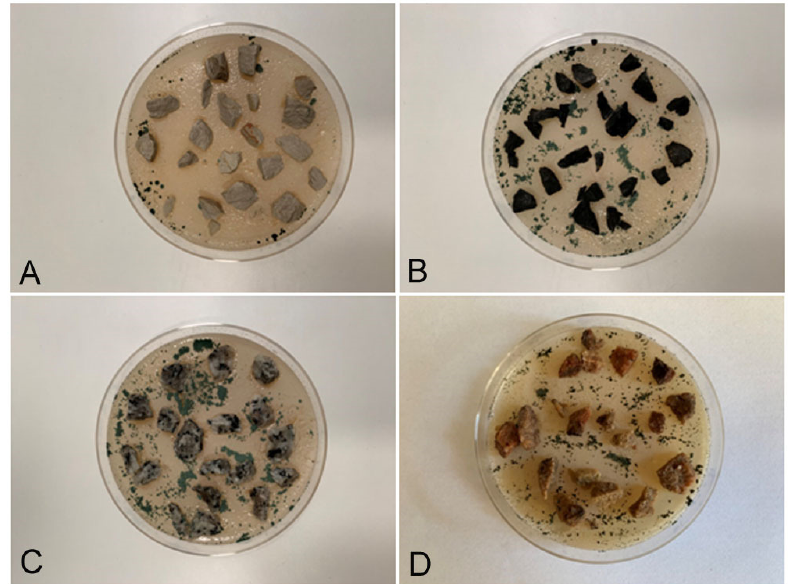
Figure 7. Fungi growing on SNA medium after two months: ( A )—marl, ( B )—melabasanite, ( C )— grandiorite, and ( D )—sandstone, photo A. Chlebicki.